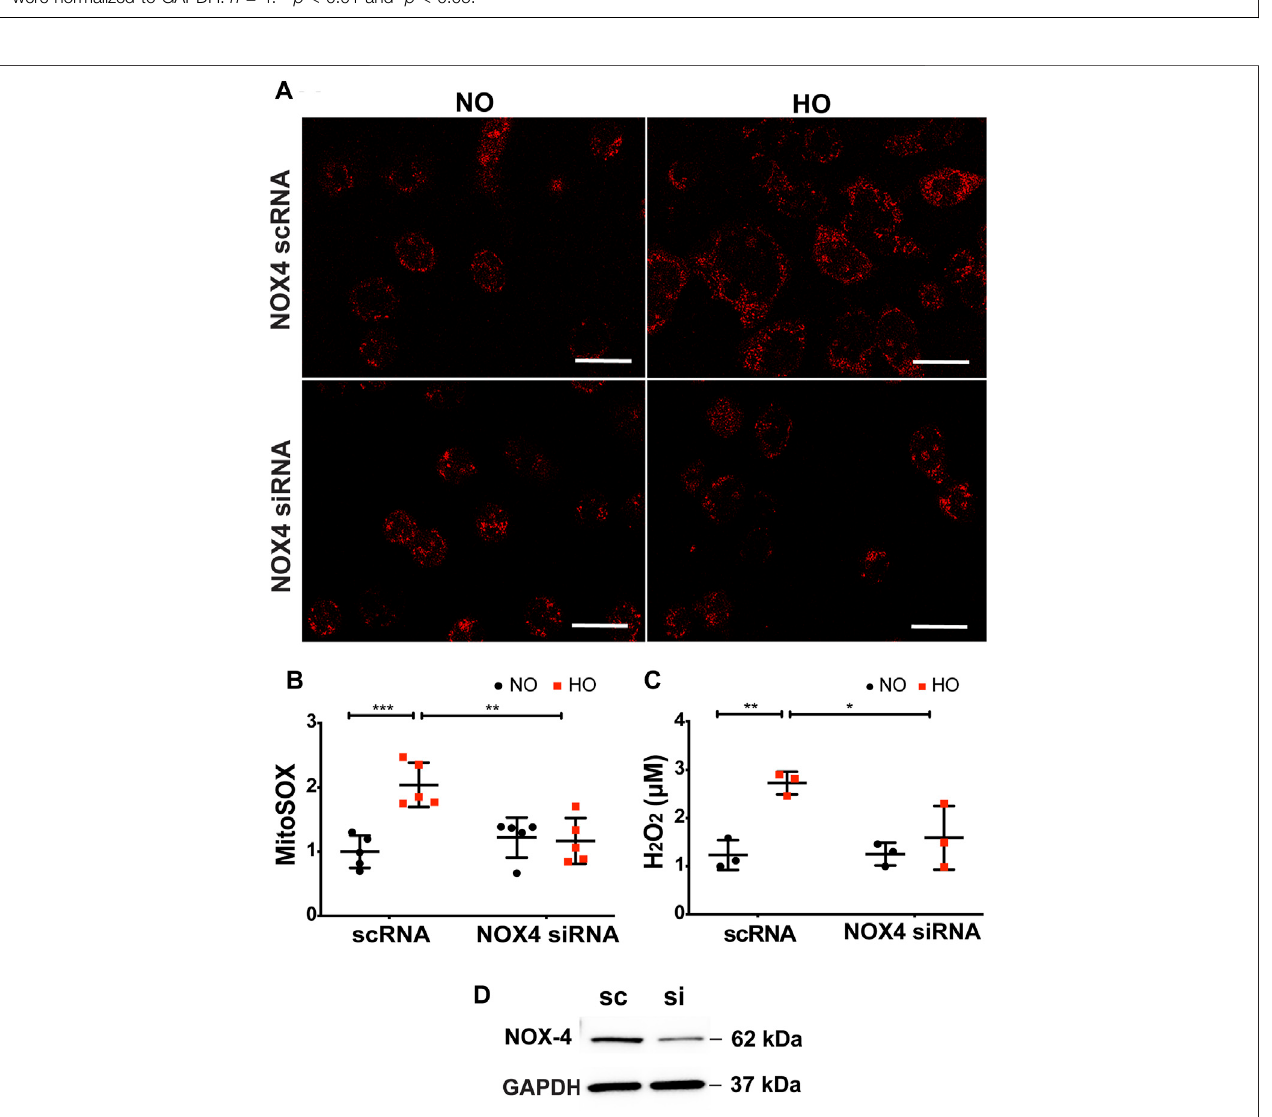
FIGURE 8 | Silencing NOX4 reduces HO-induced increase in mt ROS production and apoptosis. (A) Representative confocal images of scRNA and NOX4 siRNA treated MLE-12 cells exposed to NO or HO and stained with MitoSOX (B) Quantitative data of mt ROS intensity measured as arbitrary units showed a decrease in HO- inducedmtROSwithinhibitionofNOX4activity (C) AmplexredH 2 O 2 assayofthecellculturesupernatantshowedincreasedreleaseofH 2 O 2 fromMLE-12cellsexposed to HO compared to NOX4 siRNA treated cell supernatant (D) Immunoblots for NOX4 protein showed a signi fi cant reduction in the siRNA treated cells relative to control scRNA cells con fi rming ef fi cient transfection. n = 3. *** p < 0.001, ** p < 0.01, * p < 0.05.